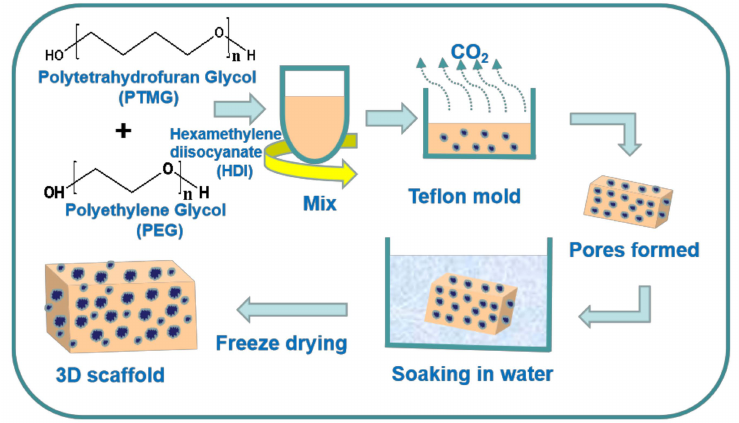
Figure 1. Preparation process of the polyurethane (PU) sca ff